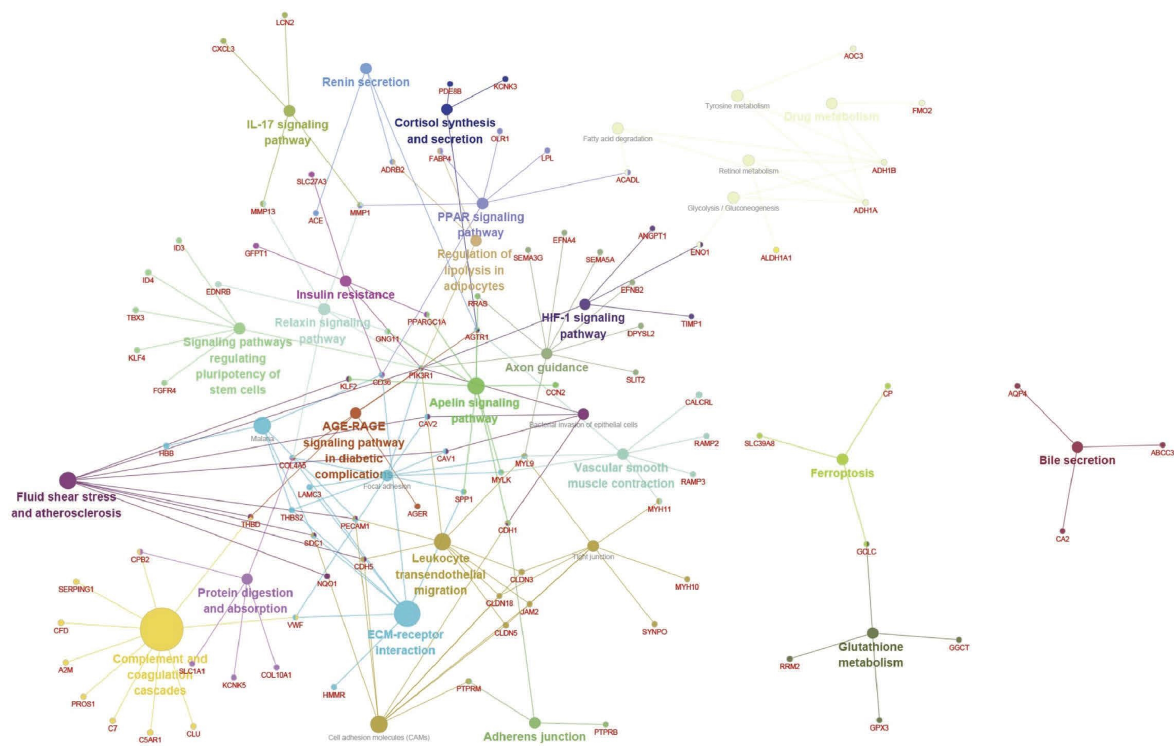
Figure 4: Te results of KEGG and the REACTOME pathway analysis with the CLUGO plugin in Cytoscape